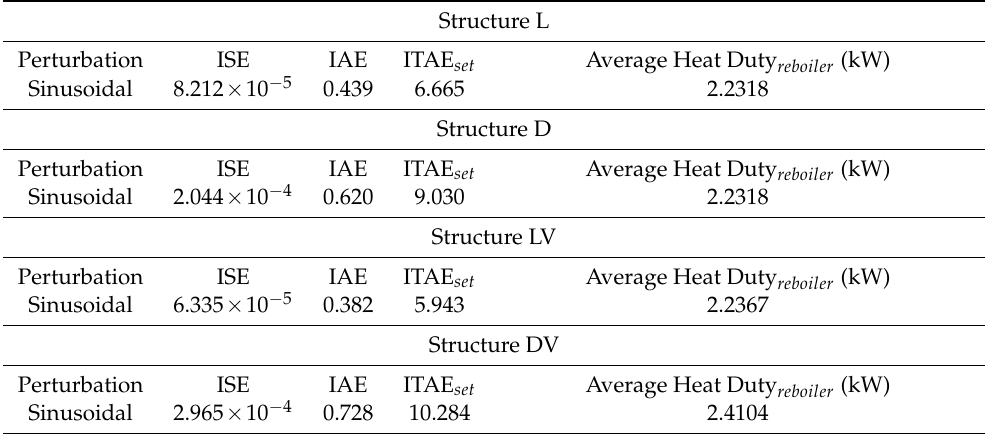
Table 14. Summary of the error rates of the control structures in the face of simultaneous disturbances in the composition and feed